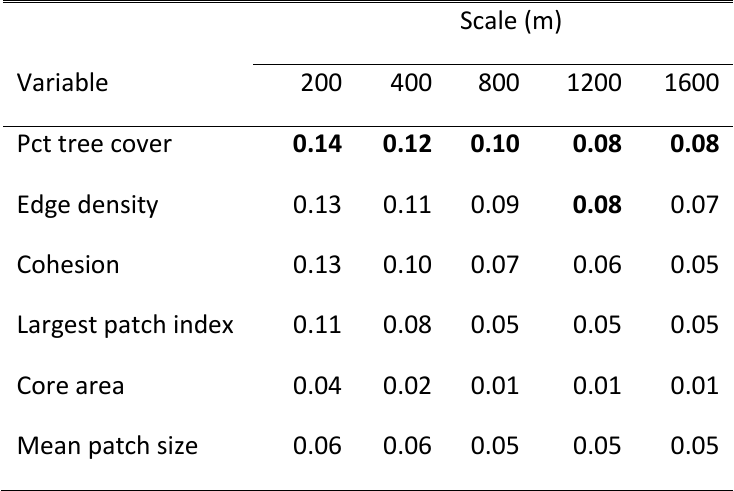
Table A1.1. Average R 2 value for each variable for all species at 5 landscape scales, using quadratic models. The strongest measures at each scale are